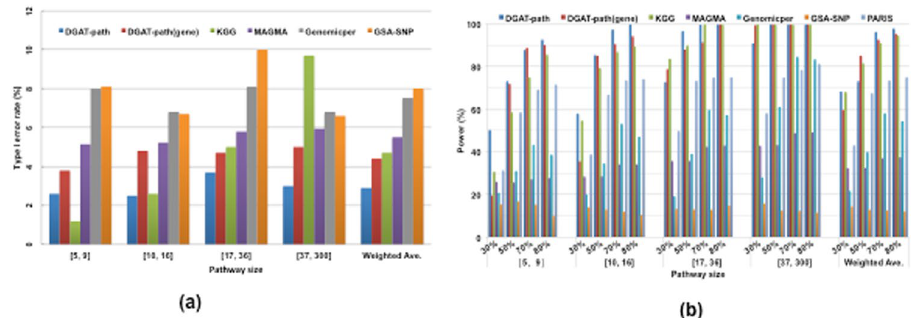
Figure 3. Comparisons of methods under different pathway sizes and percentages of significant SNPs by ( a ) the type I error rates and ( b ) the power at the nominal P-value of